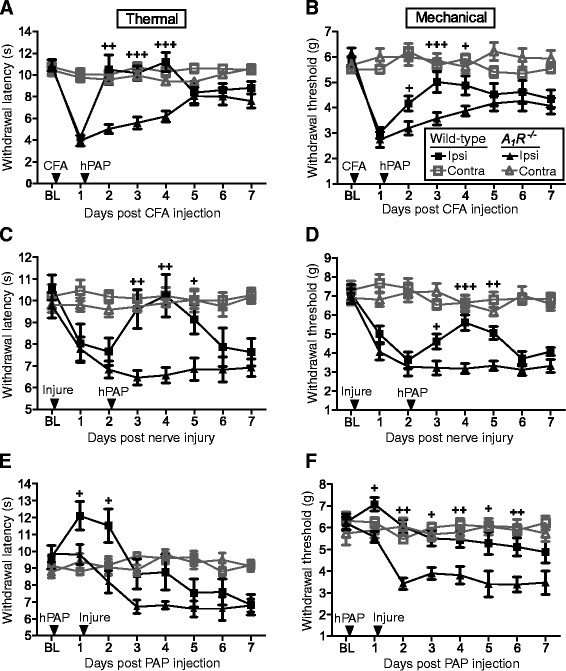
PAP has long-lasting, localized antinociceptive effects in chronic inflammatory and neuropathic pain models. (A, B) CFA was injected into one hindpaw. One day later hPAP (250 mU) was injected into the ipsilateral popliteal fossa. Inflamed and non-inflamed (contralateral) hindpaws were tested for (A) thermal and (B) mechanical sensitivity. (C, D) The sural and common peroneal branches of the sciatic nerve were ligated and then transected (injure-arrow). Two days later, hPAP (250 mU) was injected into the ipsilateral popliteal fossa. Injured and non-nerve injured (contralateral) hindpaws were tested for (C) thermal and (D) mechanical sensitivity. (E, F) Preemptive study. hPAP (250 mU) was injected into the popliteal fossa. One day later, SNI surgery was performed on the ipsilateral leg. Injured and non-nerve injured (contralateral) hindpaws were tested for (E) thermal and (F) mechanical sensitivity. (A-F) Ipsi = ipsilateral hindpaw. Contra = contralateral hindpaw. Contralateral popliteal fossa was not injected. Wild-type (n = 9-10) and A1R−/− (n = 10) male mice in each cohort. Data are plotted as means ± s.e.m. T-tests were used to compare responses at each time point between genotypes, same paw comparisons. +P < 0.05, ++P < 0.005, +++P < 0.0005.